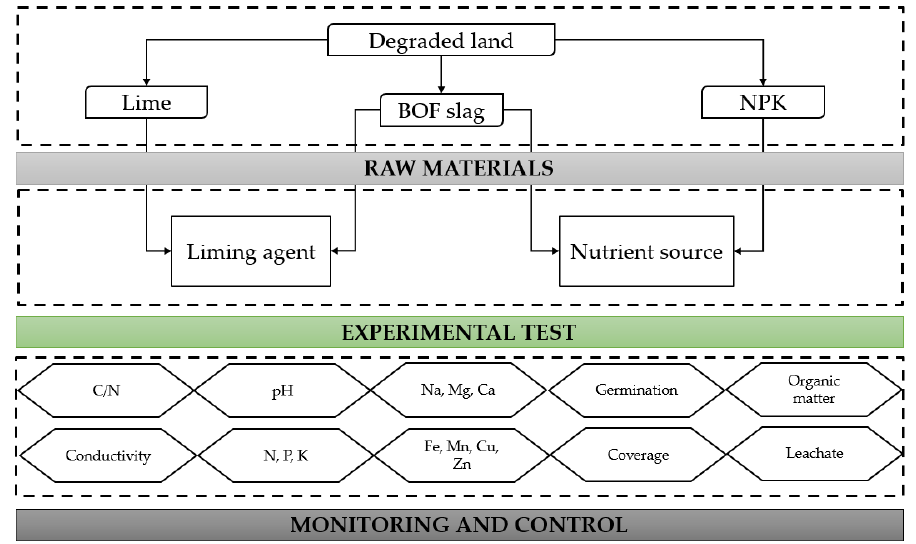
Figure 1. Experimental design program.